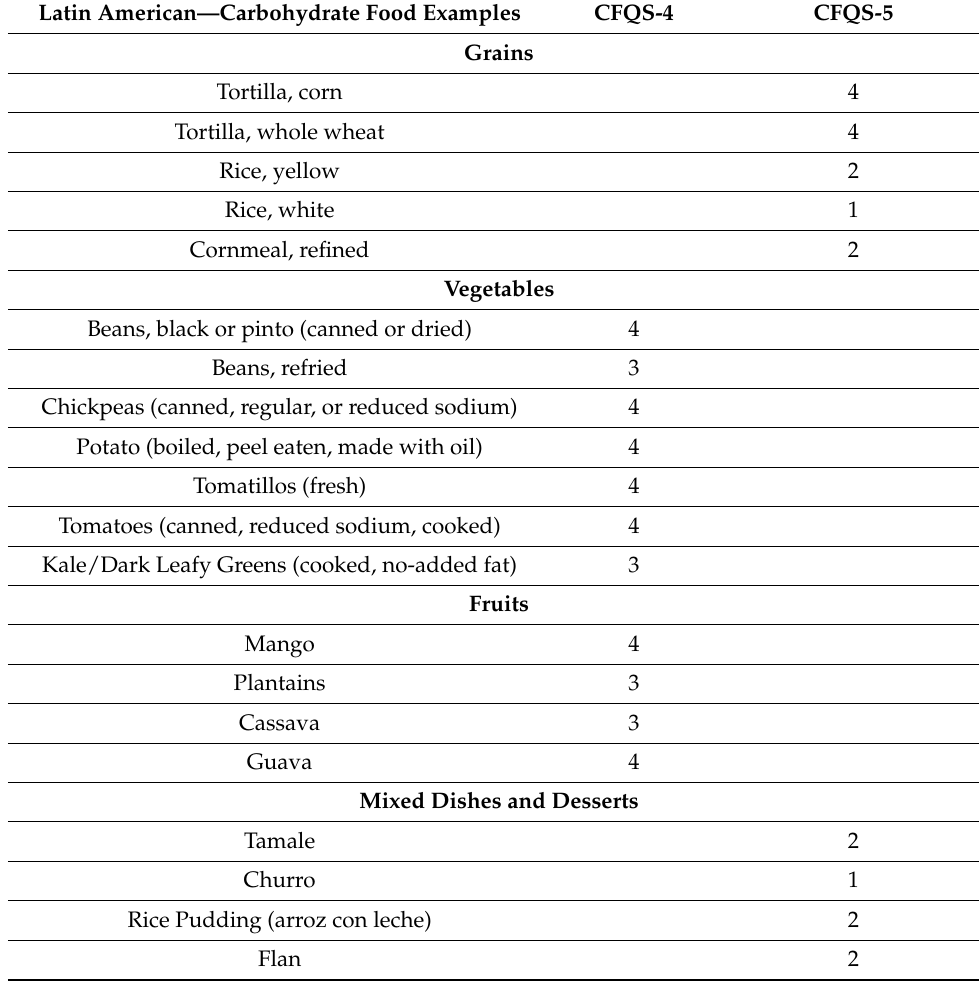
Table 2. CFQS Models Applied to Latin American Culturally Inclusive Dietary Patterns. Latin American—Carbohydrate Food